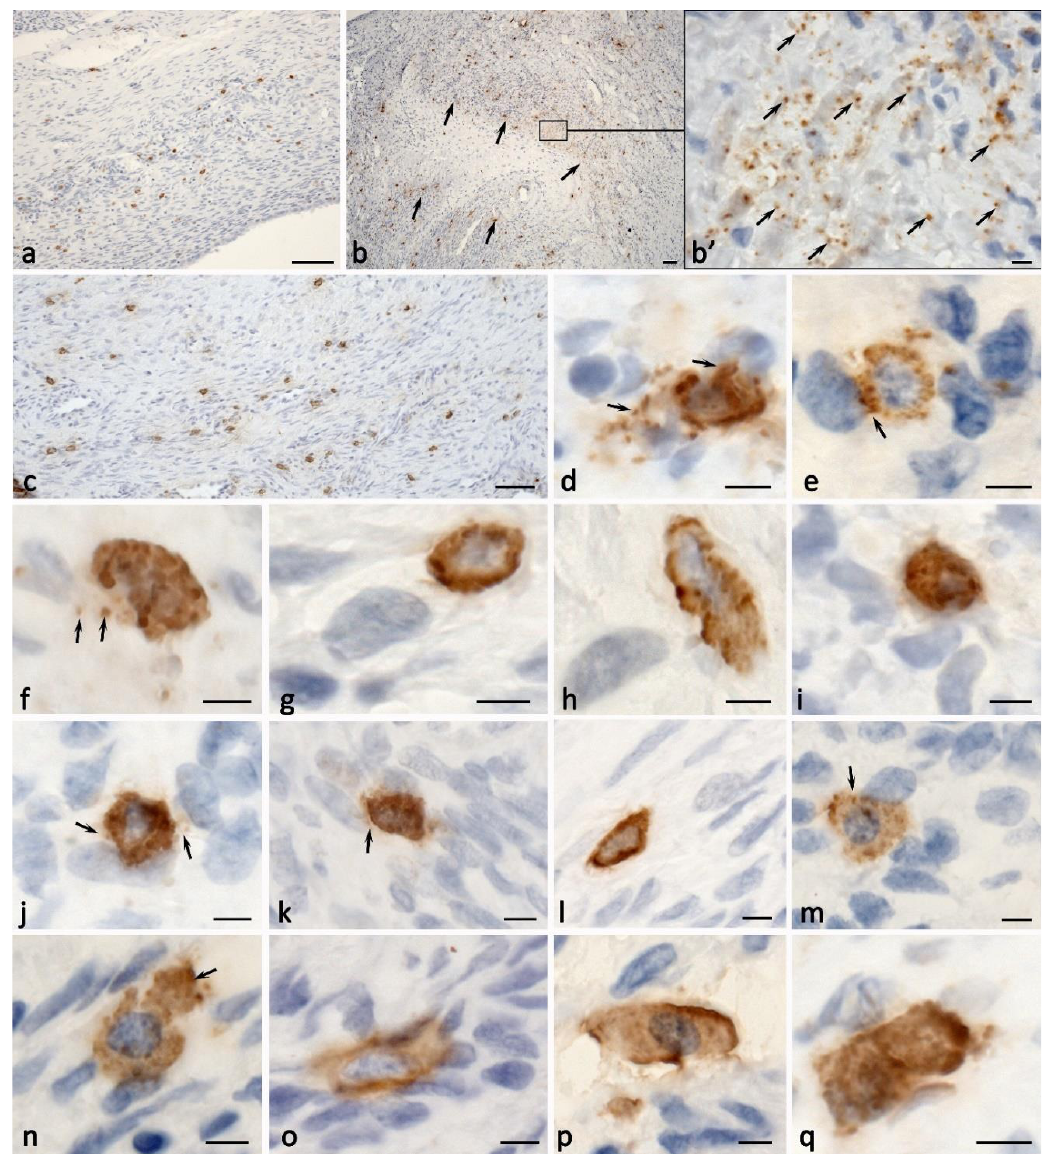
Figure 3. Expression of CPA3 in the population of ovarian mast cells under intraorgan endometrioma development. ( a ) High content of MCs in the wall of the endometrioid cyst. ( b ) Predominant location of MCs and secretory granules bordering with the area of fibrous changes in the ovarian stroma (indicated by an arrow). ( b (cid:48) ) Enlarged ( b ) fragment, there is a high content of secretory granules in the extracellular matrix (indicated by an arrow). ( c ) Large amounts of MCs in the perivascular connective tissue of the ovarian stroma. ( d – m ) Variants of MC colocalization with ovarian stroma fibroblasts, with signs of active targeted secretory activity (indicated by an arrow). ( n ) Release of an autonomous fragment of a protease-positive cytoplasmic region (indicated by an arrow). ( o ) MC contacting with numerous cells of the cytogenic stroma. ( p ) The extracellular matrix remodeling. ( q ) Contacting MCs. Scale: ( a – c ) 50 µ m, the rest—5 µ